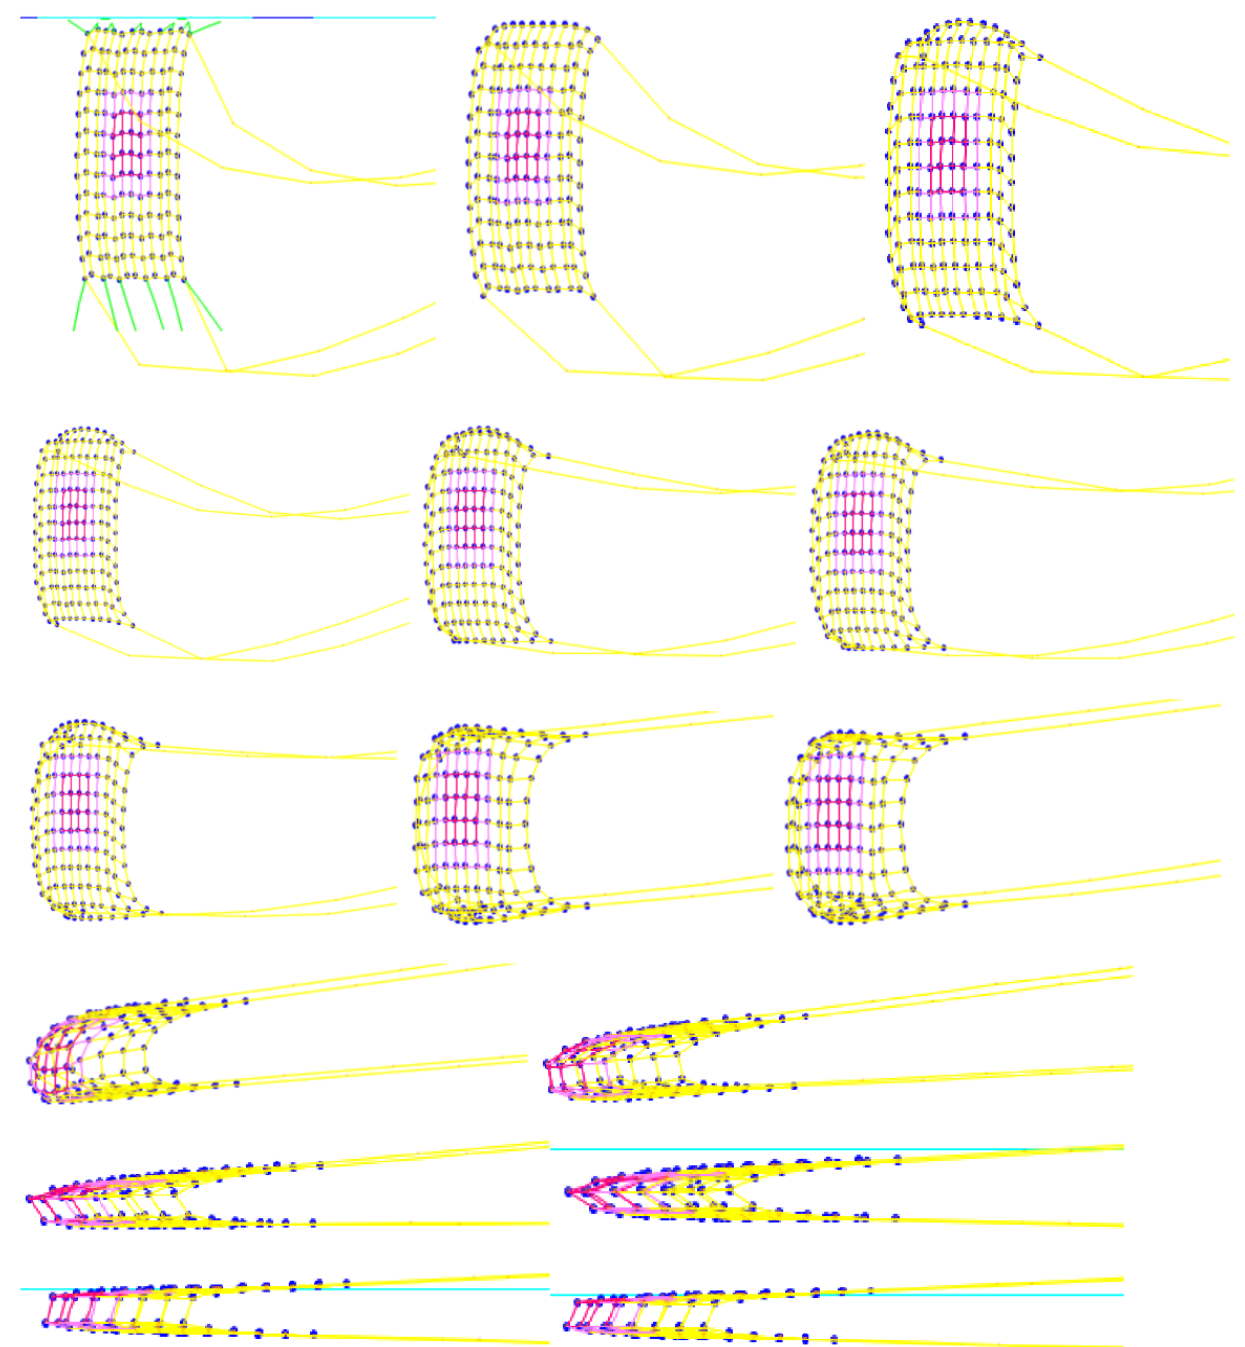
Figure 33. Shape changes of the flexible trawl in straight-line towing at v = 2 m/s.